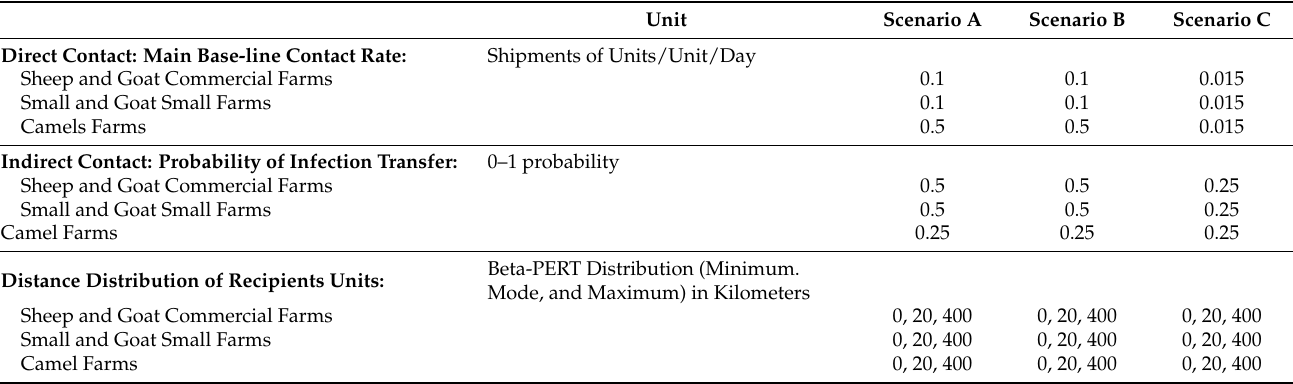
Table 1. Direct and indirect contact and movement